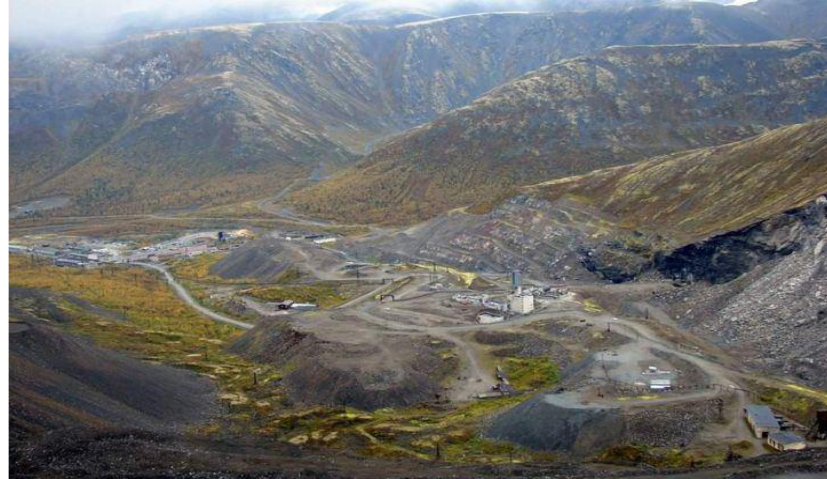
Figure 1. Gold mines were illegally exploited by Armenia in the Kalbajar region.